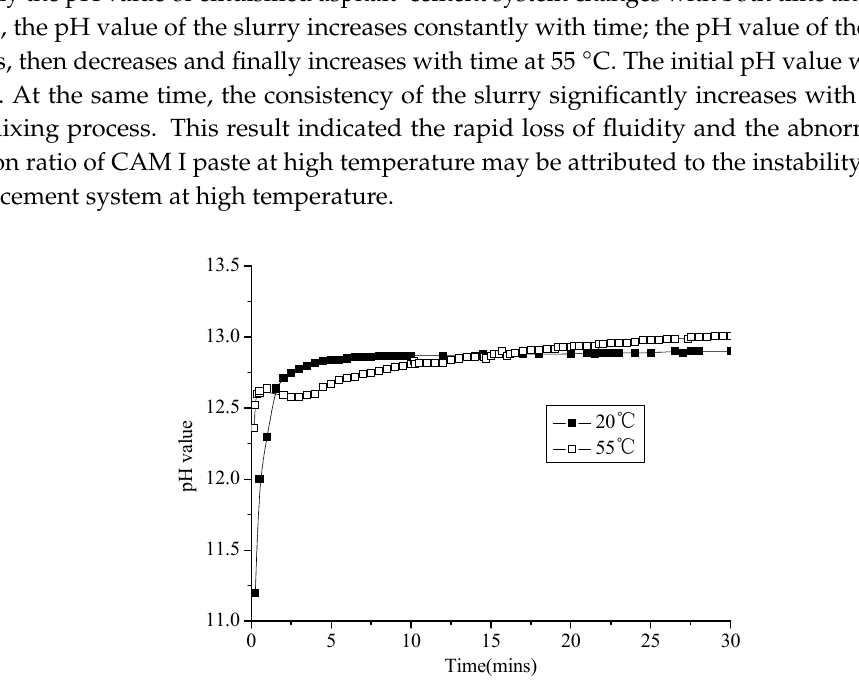
Figure 10. pH value of emulsified asphalt–cement system changes with time at different temperatures.